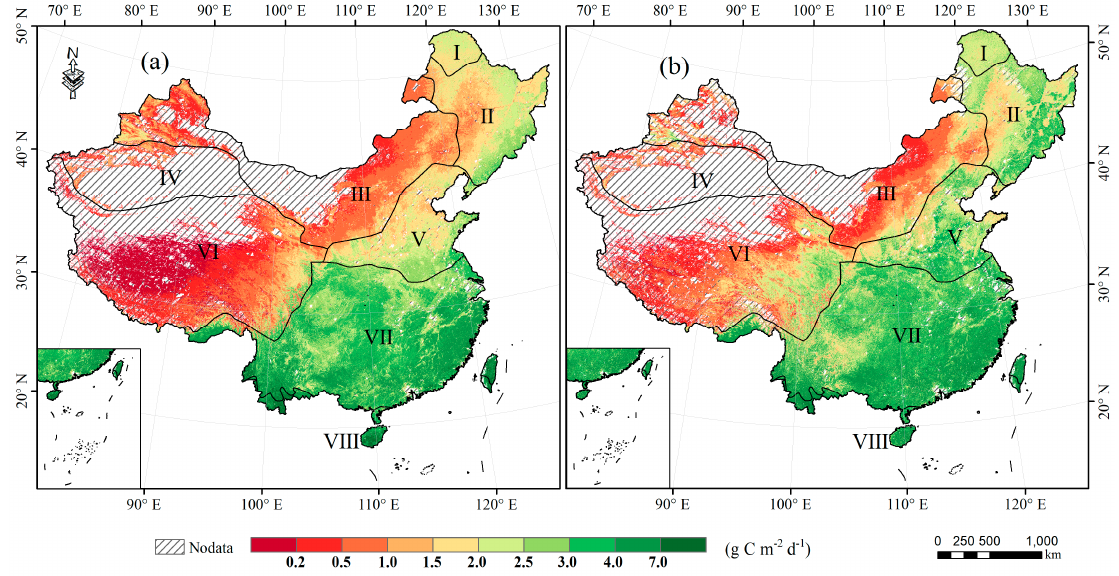
Figure 2. Spatial distribution of multiyear mean GPP across China from 2001 to 2015. ( a ) and ( b ) represent MODIS and breathing Earth system simulator (BESS) GPP, respectively. The black line delineates the boundary of eight climate zones. The insert shows the full southern extent of China’s islands.